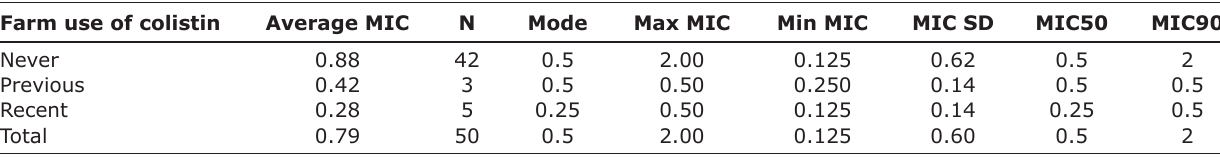
Table-3: Distribution pattern of Colistin MIC (µg/mL) in clinical Avian E. coli isolates obtained from South Africa in 2016. Farm use of colistin Average MIC